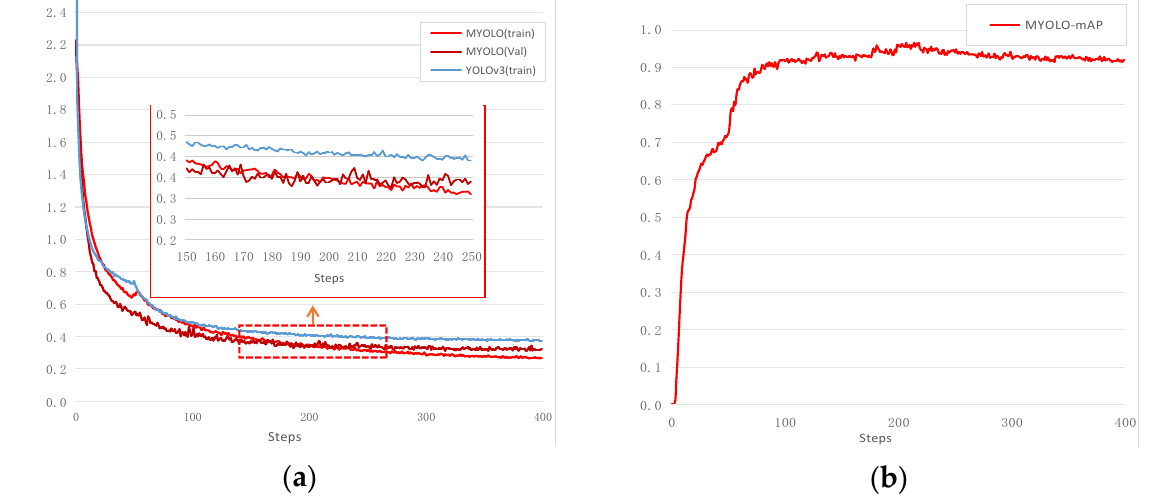
Figure 11. Loss curves and validation set 𝑚𝐴𝑃 values during training. ( a ) Loss curve during train- ing; ( b ) Validation set 𝑚𝐴𝑃 curve during training.